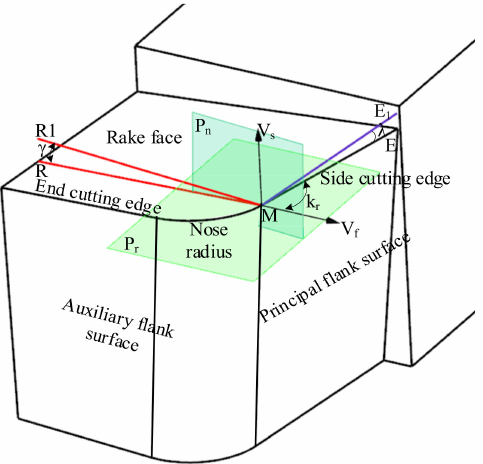
Figure 1. Definition of rake angle and inclination angle of turning